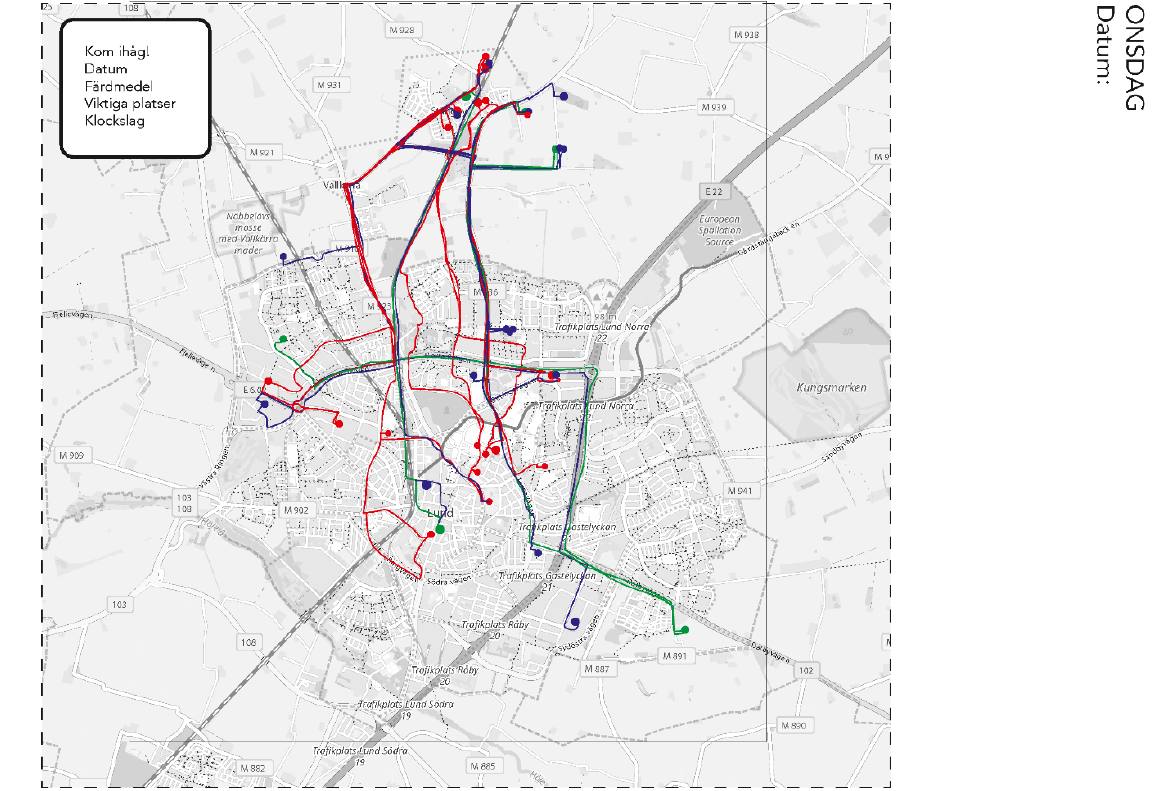
Figure 3. One of the maps from Wednesday, tracking the various routes of the respondents. Source: